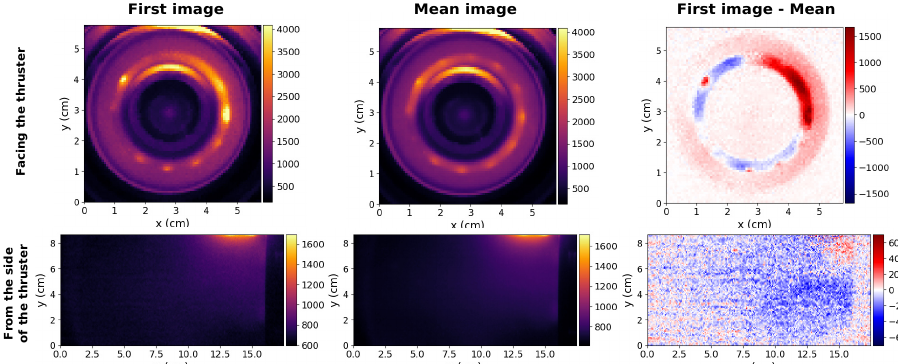
Figure 2. Example of images captured with the high-speed camera in front of the thruster ( top row ) and from the side ( bottom row ). For both cases, the discharge parameters are : I H = 20.05 Amps ( I H / I H , crit = 1.09), Q = 1.8 mg · s − 1 and U d = 200 V. (Left) Raw image; (Middle) mean image over the whole acquisition time interval; and (Right) raw image minus the mean image. The light intensity is given in counts, encoded between 0 and 4096 for the raw images and the mean images and between − 4096 and +4096 for the raw images minus the mean